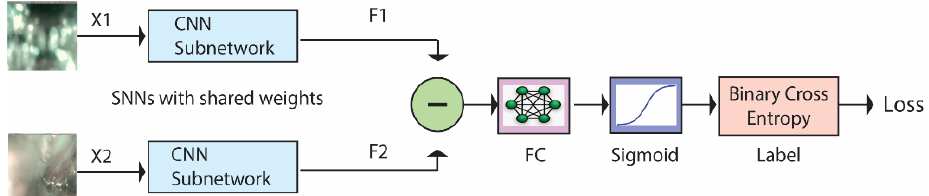
Figure 2. Siamese Neural Network architecture.